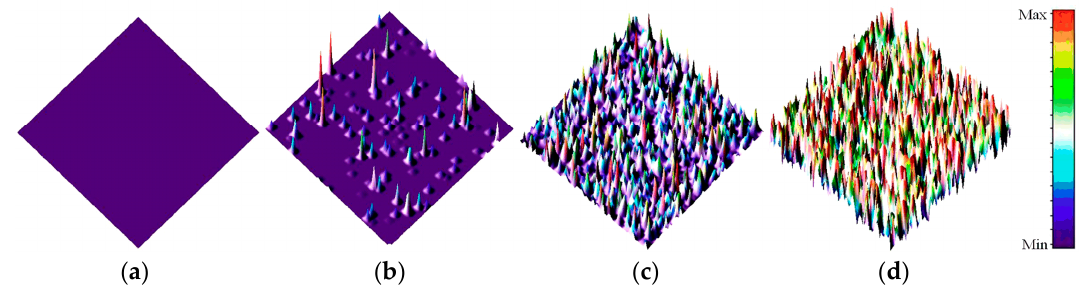
Figure 2. 3-D surface plot of dark images from CIS (#1) After 3 MeV proton radiation (integration time: 61.56 ms): ( a ) before radiation; ( b ) proton fluence: 1 × 10 10 p/cm 2 ; ( c ) proton fluence: 5 × 10 10 p/cm 2 ; and ( d ) proton fluence: 1 × 10 11 p/cm 2 .